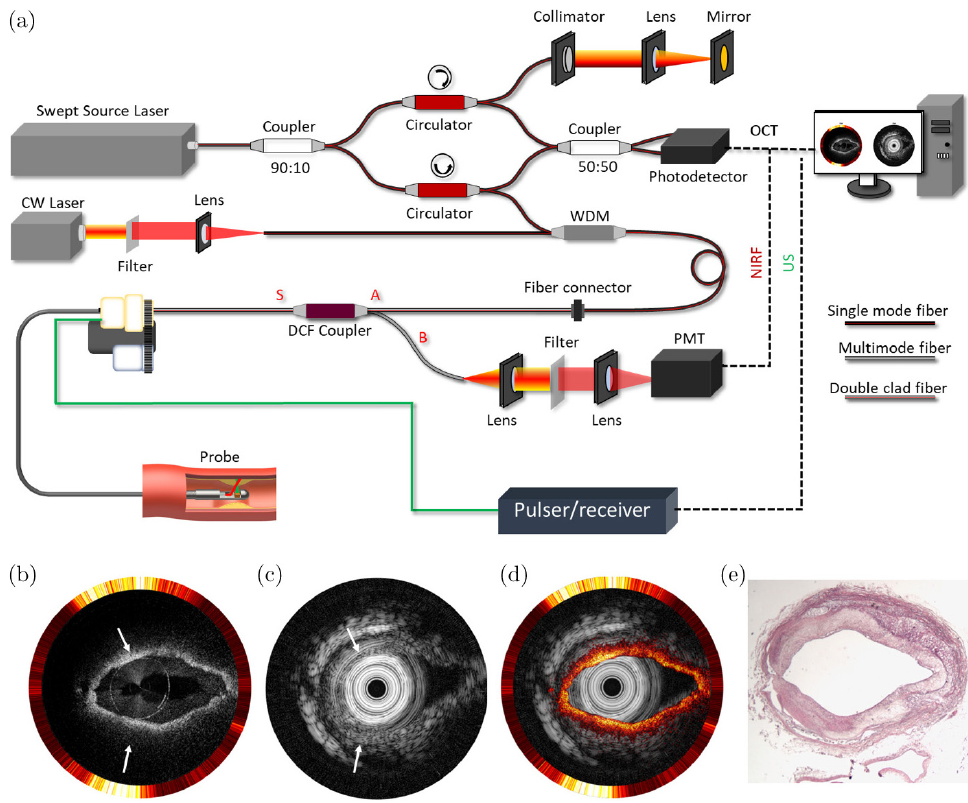
Fig. 5. Integrated IVOCT-US-NIRF imaging of an ex vivo rabbit aorta. (a) System schematic. (b) IVOCT-NIRF (inner: IVOCT, outer: NIRF). (c) US image. (d) Overlaid image of (b) and (c). (e) Histology. WDM: wavelength-division multiplexing. DCF: double clad ¯ber. PMT: photomultiplier tube. CW: continuous wavelength. OCT: optical coherence tomography. US: ultrasound. NIRF: near infrared